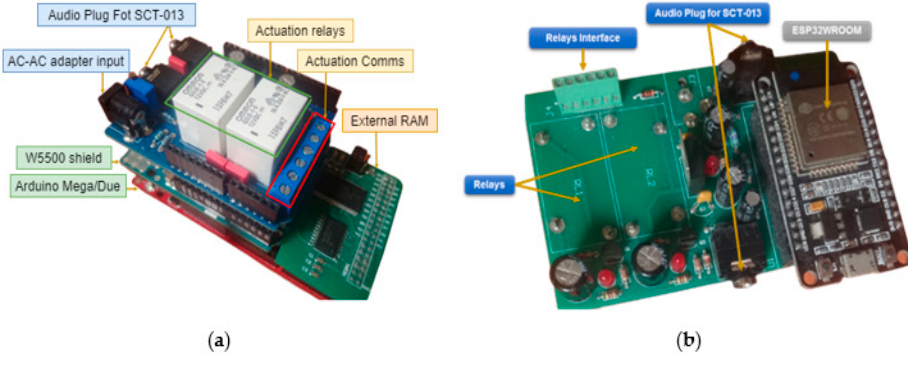
Figure 7. IoTivity HAN servers (appliance interface nodes): ( a ) AVR/ARM DAQ node prototype; ( b ) ESP32 node DAQ Prototypes.